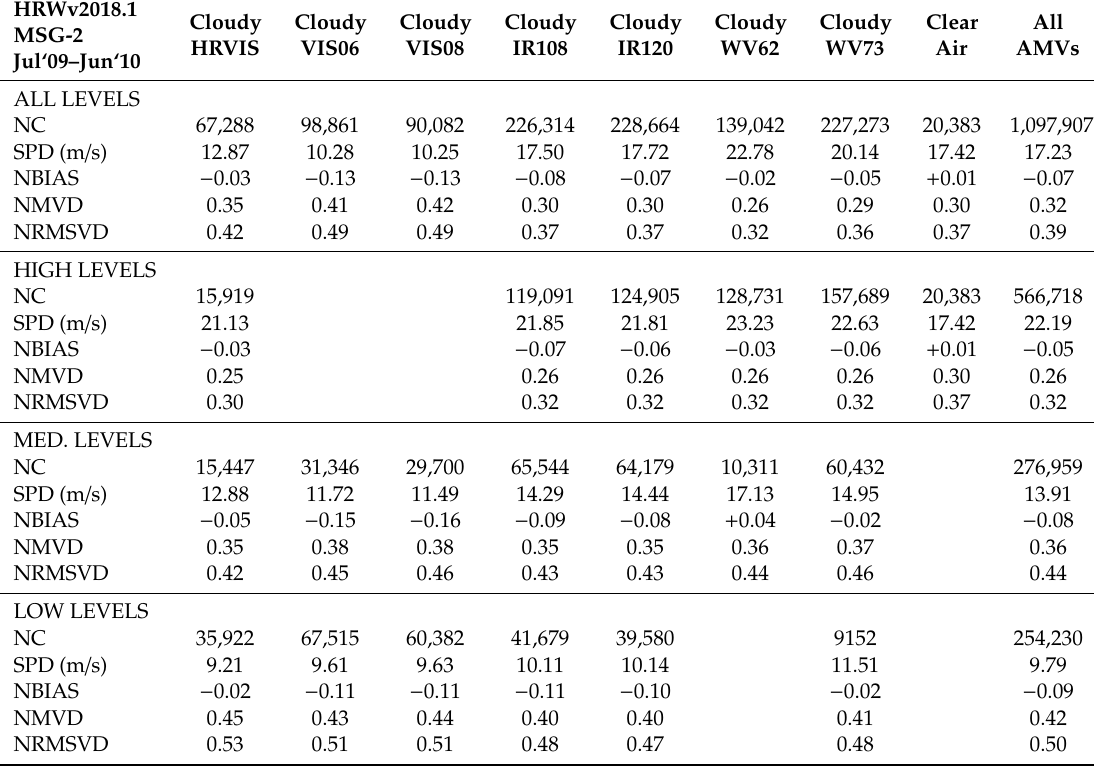
Table4. ValidationforNWC / GEO-HRWv2018.1AMVsagainstradiosondewinds, consideringallAMVs together and in three separate layers: high levels: 100–400 hPa; medium levels: 400–700 hPa; low levels: